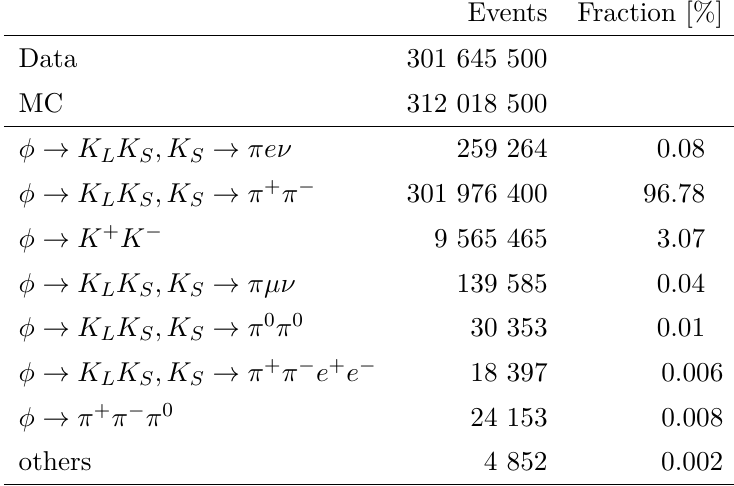
the distance from the nominal interaction point, the φ - clu